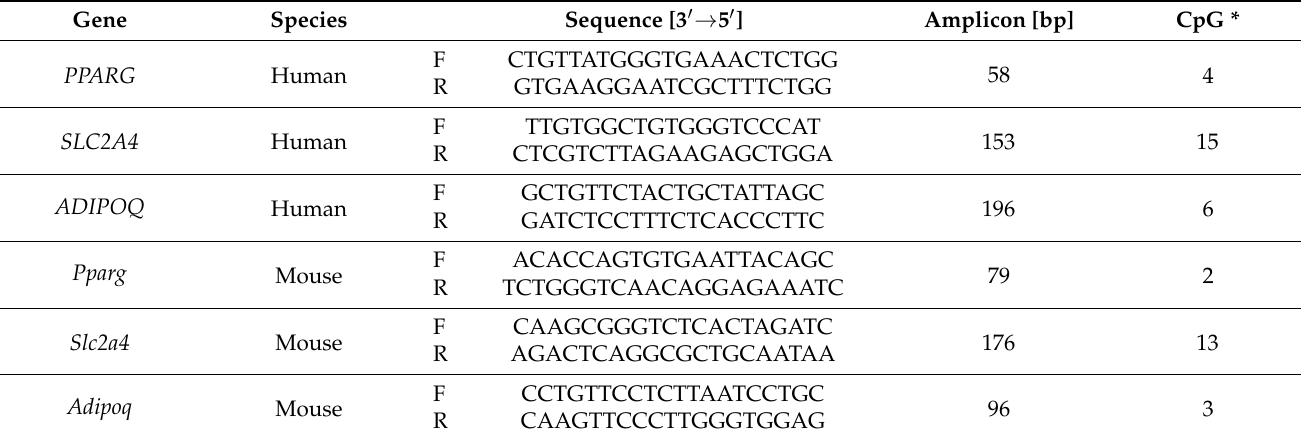
Table 1. Primers sequences used for DNA methylation